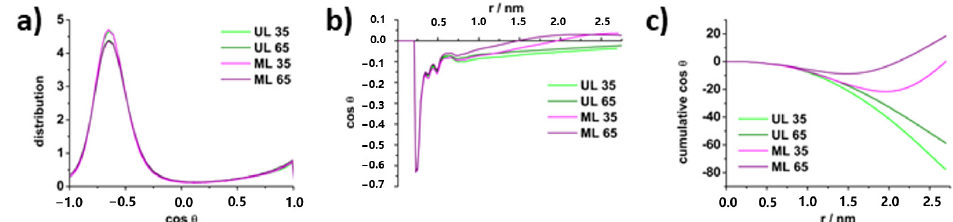
Figure 4. ( a ) angular distribution functions for water molecules in the first hydration shell of DPPS and DPPG lipids; ( b ) tilt of water molecules as a function of distance from the membrane; ( c ) the sum over all solvent molecules of cos θ as a function of distance from the membrane.